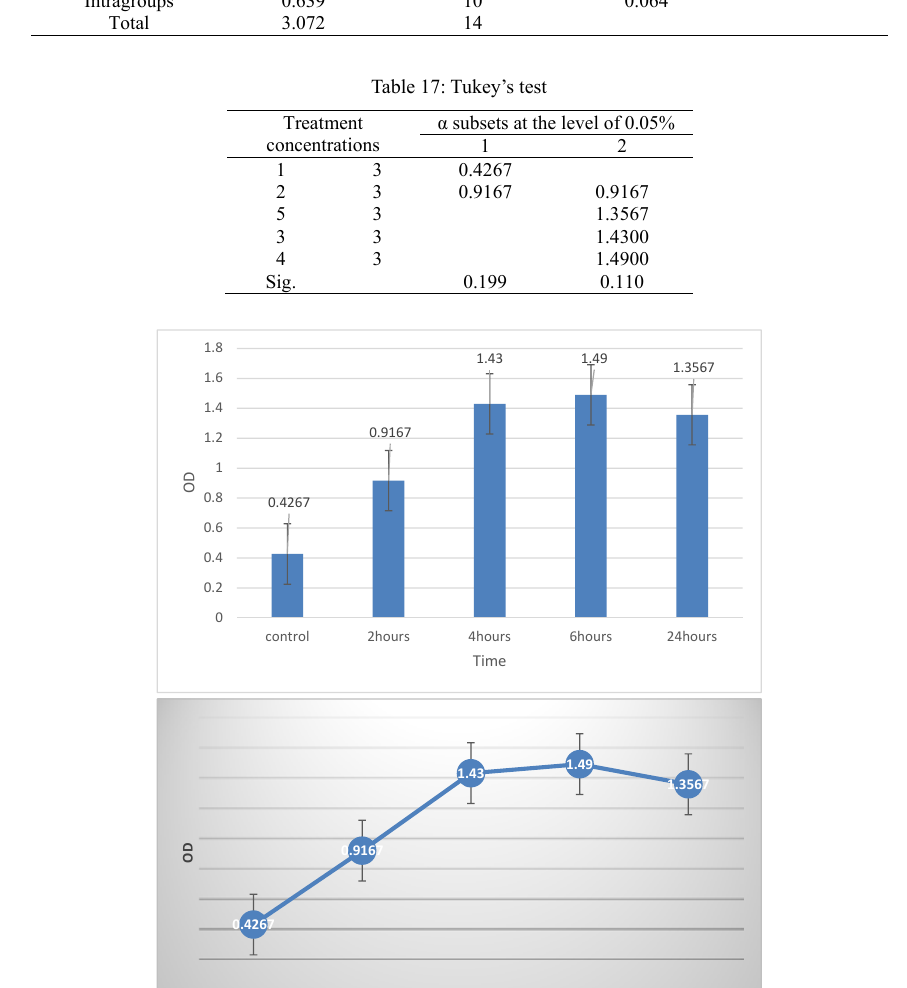
Table16: Analysis of variance of OD at different antibacterial concentrations of the solution of nisin-conjugated CuO NPs Source of variations Sum of squares Degree of freedom Mean of squares F Sig. Intergroups